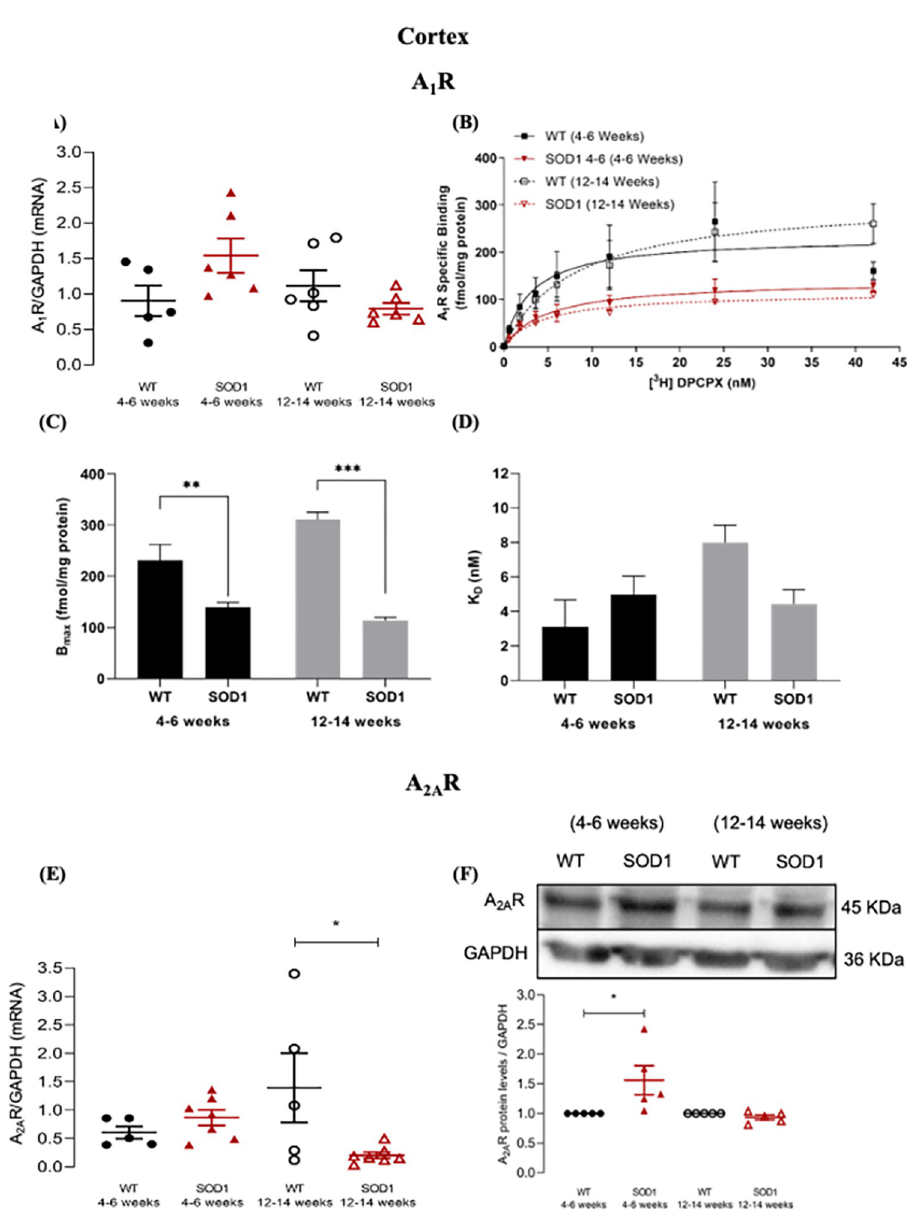
Fig 1. A 1 R and A 2A R mRNA expression and protein levels in the cortex of pre-symptomatic and symptomatic SOD1 G93A mice. (A) Cortical A 1 R mRNA expression in pre-symptomatic (4–6 weeks old) and symptomatic (12–14 weeks old) SOD1 G93A and age-matched WT mice. The Y-axis represents the A 1 R transcript level of the normalized A 1 R/GAPDH ratio in each condition. (B) Saturation binding curves of A 1 R for pre-symptomatic and symptomatic SOD1 G93A and age-matched WT mice, in cortex. The Y-axis represents the specific binding of A 1 R expressed in fmol/ mg protein plotted against increased concentrations of [ 3 H] DPCPX (nM) (abscissae). (C) Maximum density of A 1 R (Bmax) in cortex of pre-symptomatic and symptomatic SOD1 G93A and age-matched WT mice. (D) DPCPX equilibrium dissociation constant (K D ) expressed in nM, for pre-symptomatic and symptomatic SOD1 G93A and age- matched WT mice, in cortex. (E) Cortical A 2A R mRNA expression in pre-symptomatic and symptomatic SOD1 G93A and age-matched WT mice. The Y-axis represents the A 2A R transcript level of the normalized A 2A R/GAPDH ratio in each condition. (F) Cortical A 2A R protein levels in pre-symptomatic and symptomatic SOD1 G93A and age-matched WT mice. The Y-axis represents the A 2A R/GAPDH ratios normalized to age-matched WT samples. Upper panels show representative immunoblots for each condition. Data are expressed as mean ± SEM (n = 4–7 animals for all conditions); � p < 0.05, �� p � 0.01, ��� p � 0.001, two-way ANOVA with Holm-Sidak correction for multiple